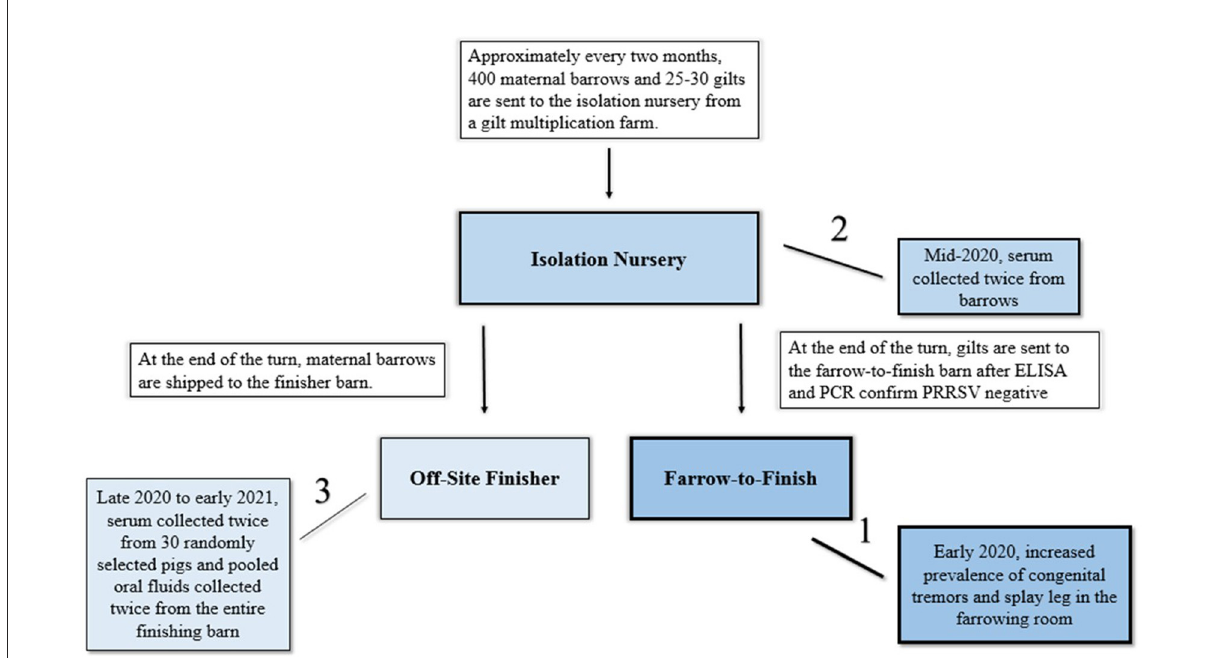
FIGURE1 Depiction of the relationship between the isolation nursery barn, the farrow-to-finish site, and off-site finisher barn and timeline of events during this investigation of atypical porcine pestivirus persistence (APPV) in pigs. Arrows indicate movement of pigs while lines indicate order of events of sampling which corresponds to the shading of blue in the graphic.